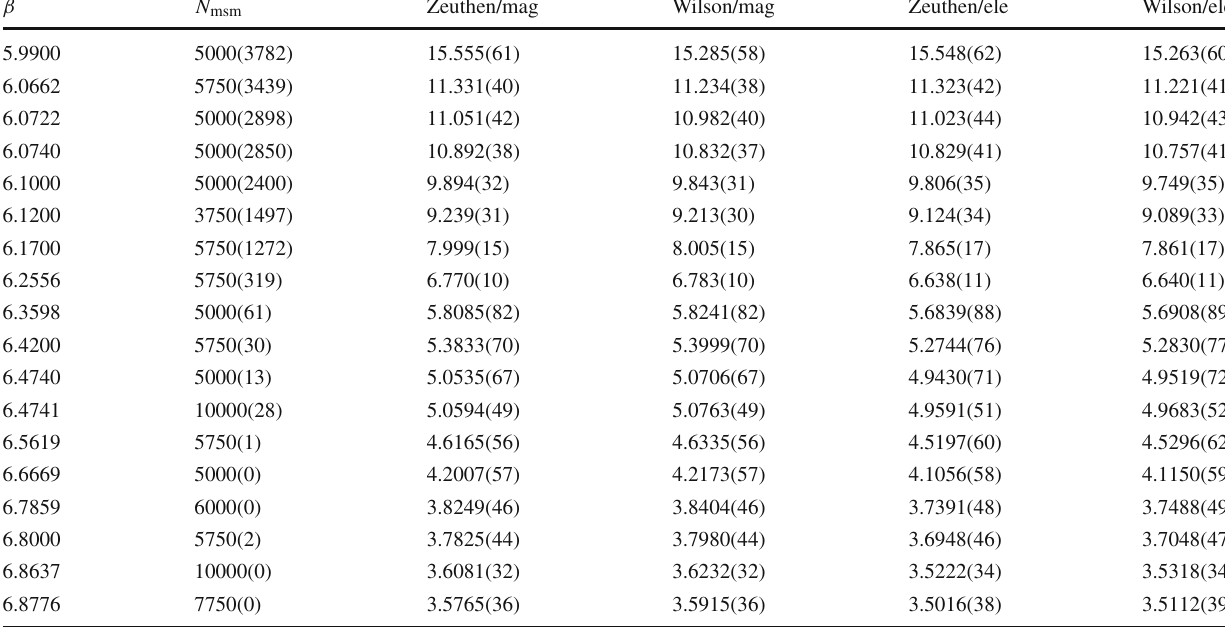
Table 13 GF coupling data for L / a =